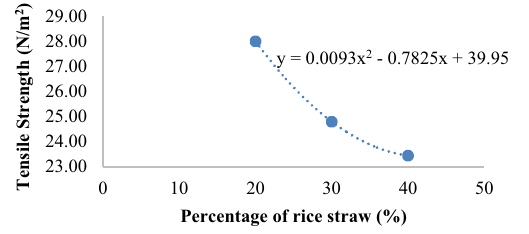
Fig. 3 The correlation between tensile strength and the percentage of water hyacinth contents in organic mulch sheet